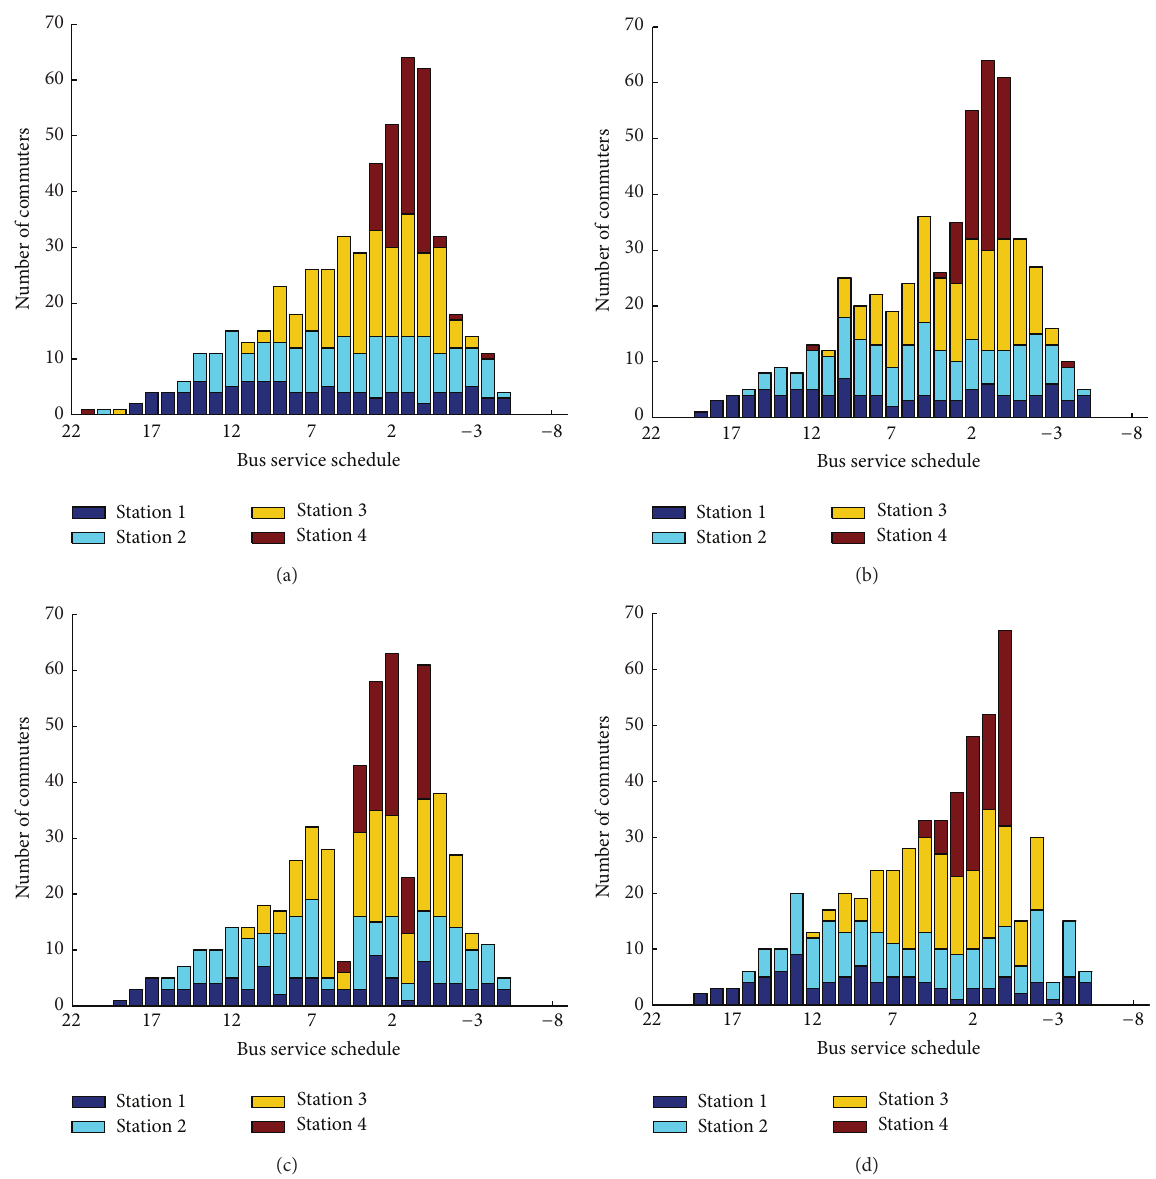
Figure 14: Snapshots of commuters’ distribution in the short-term memory experiment. ((a) day 500, (b) day 1000, (c) day 2000, and (d) day 3000.)